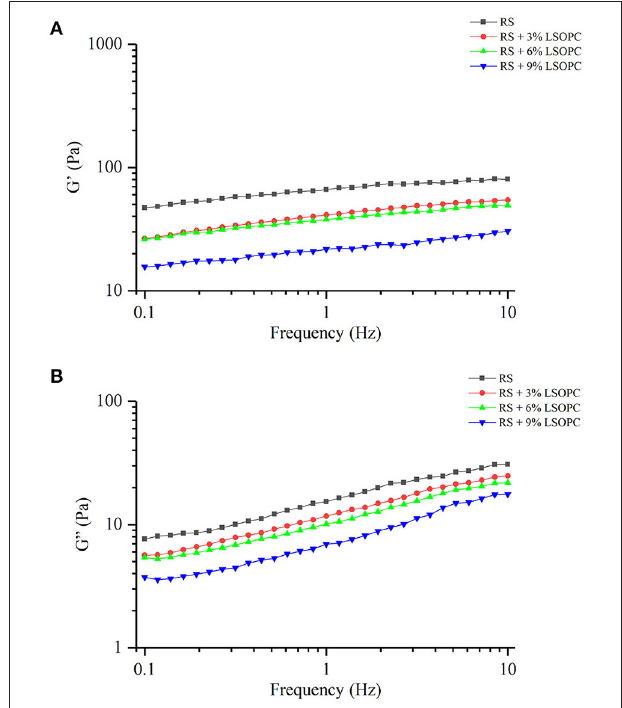
Frontiers in Nutrition |